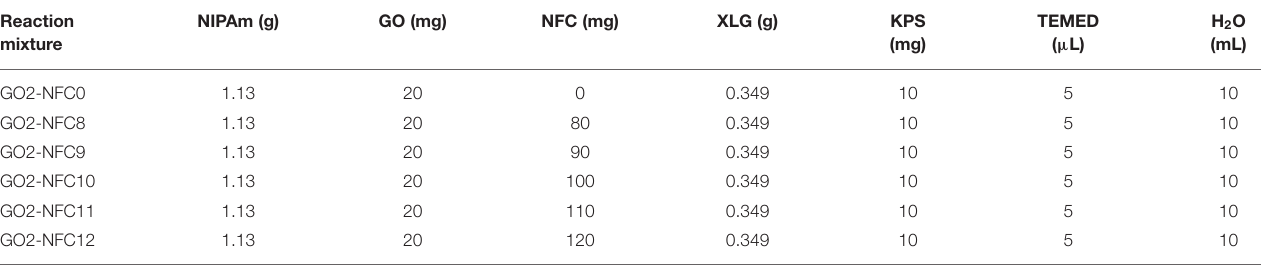
TABLE 1 | Compositions of intelligent hydrogel reaction mixture for three dimensional (3D) printing. Reaction mixture